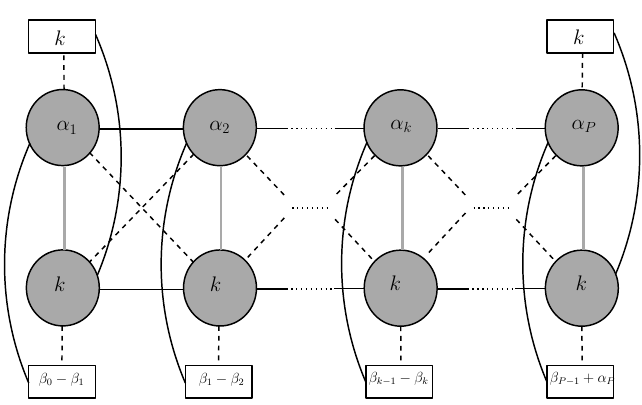
Figure 5 . A generic quiver field theory whose IR is dual to the holographic background defined by h 8 = k and h 4 as in (A.5). The solid black lines represent (4 , 4) hypermultiplets, the grey lines represent (0 , 4) hypermultiplets and the dashed lines represent (0 , 2) Fermi multiplets, all of them in the bifundamental representations of the gauge groups. N = (4 , 4) vector multiplets are the degrees of freedom in each gauge node.